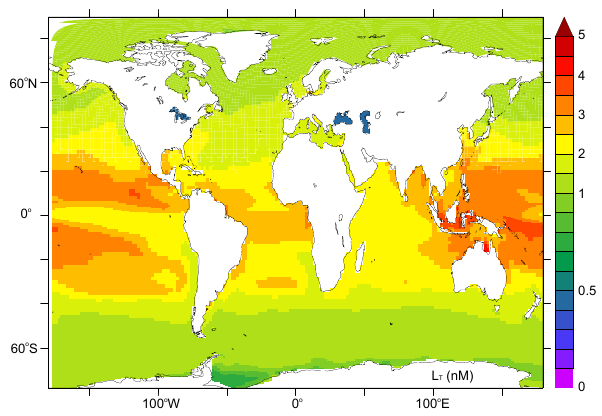
Fig. 1. The distribution of Fe binding ligands in the upper 100m when they are computed from an empirical relationship between L T and DOC (Wagener et al.,